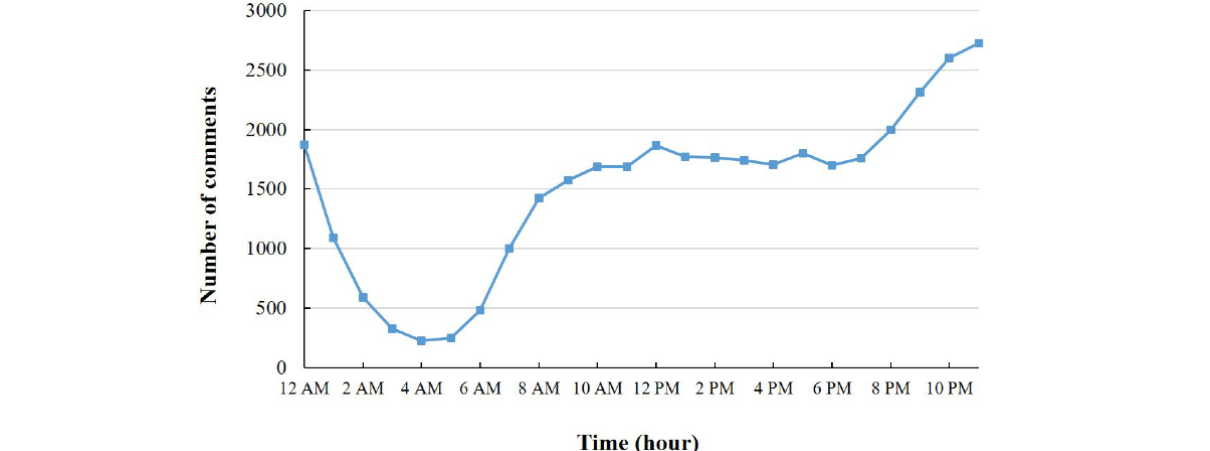
Figure 3. Distribution of the comments in the online albinism community by hour of the